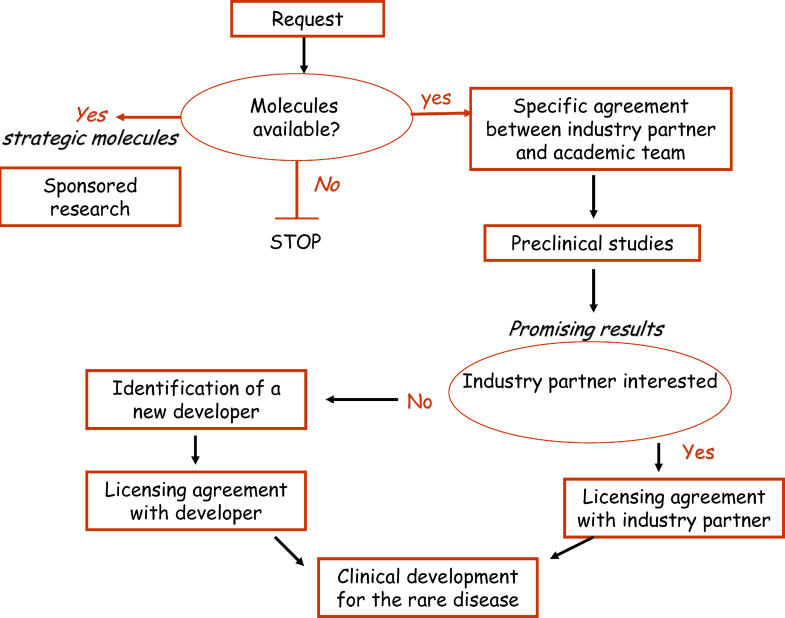
How ERDITI Functions as a Public–Private PartnershipThe working procedure guarantees continuity all the way from research to development of a drug. After the ERDITI scientific advisory board's assessment of the request, industry partners are questioned about the availability of molecules belonging to the pharmacological classes of interest. Several molecules may be of strategic interest for the industry partner, and sponsored research should be negotiated directly outside the framework of this working procedure. If there are no molecules available, the process ends. If molecules are available, a specific agreement is signed and the industry partner provides molecules required for preclinical studies. If promising results arise from preclinical studies, the lead academic partner asks the industry partner whether it wishes to exercise the option to further develop the drug. The industry partner may decide to exploit the results and develop one of the molecules through a worldwide exclusive license. Alternatively, the industry partner may decide not to exploit the results and grant necessary license rights to a third party for the development of the molecule for treating the rare disease.